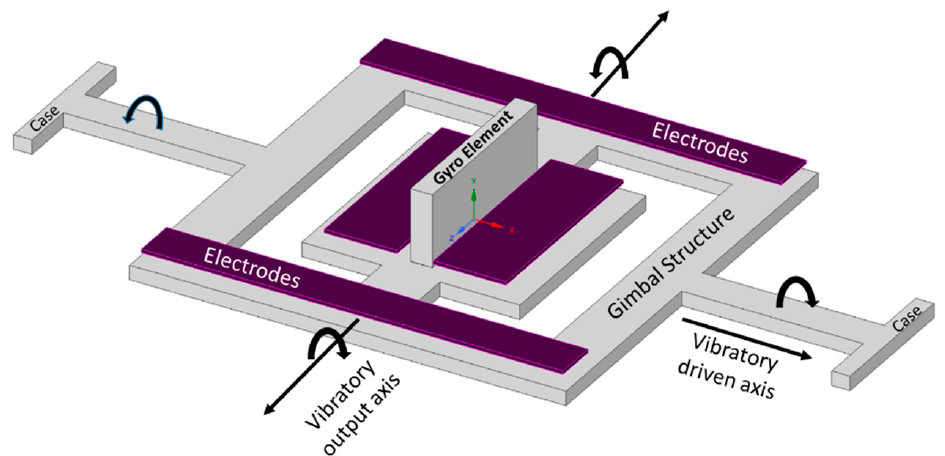
Figure 6. Schematic diagram of Draper laboratory’s micromachined gimbal gyroscope.